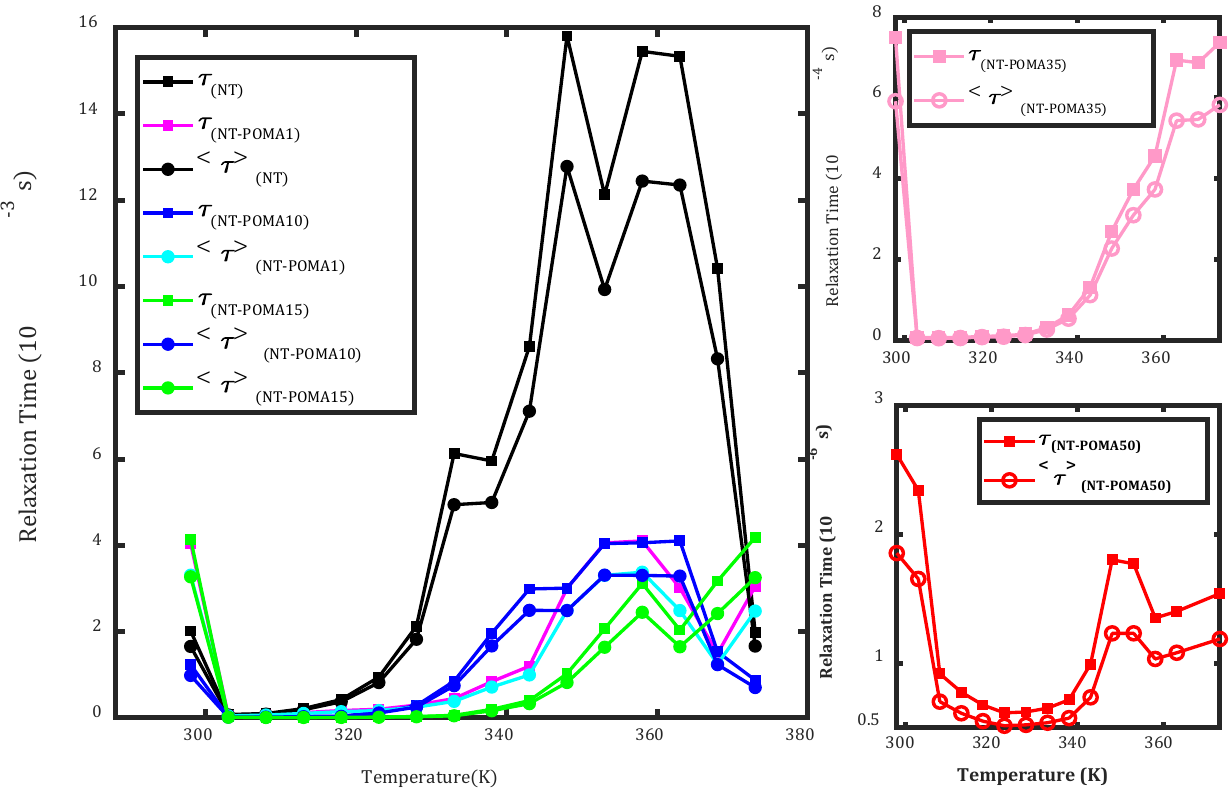
Figure 6. Temperature dependence of the average relaxation time < τ > and the relaxation time τ in the frequency domain for each sample. The data was obtained from the complex impedance for- malism.